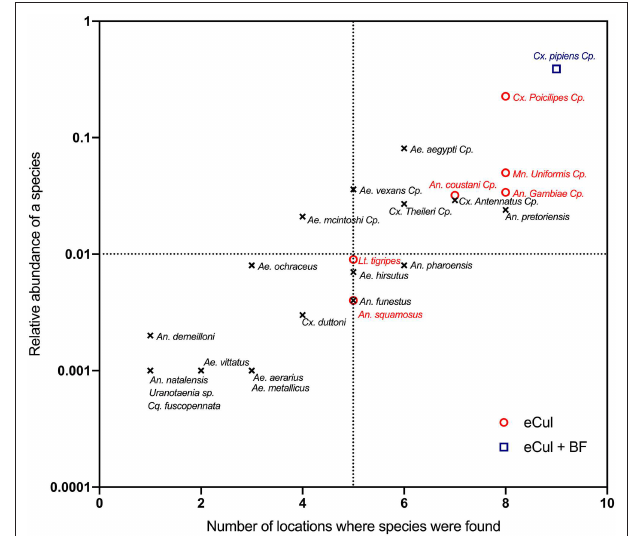
FIGURE 4 | Comparison of eDNA and adult trapping for the morphological identification of mosquitoes. Community similarity between adult trapping and eDNA (expressed as the distance in the Bray Curtis-index) was plotted against the proportion of species that were observed with the eCul or BF primers. In general, the eCul primers performed better than the BF primers, however overall similarity between the two approaches was low.